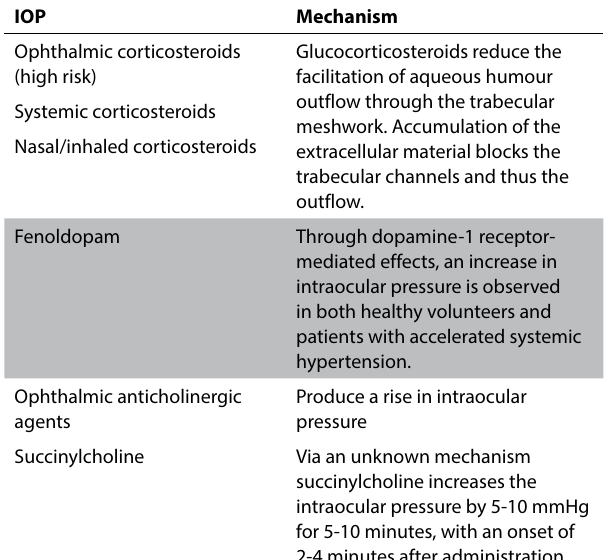
Table III: Drugs that may potentiate or induce raised intraocular pressure in 9-11,14-18 IOP